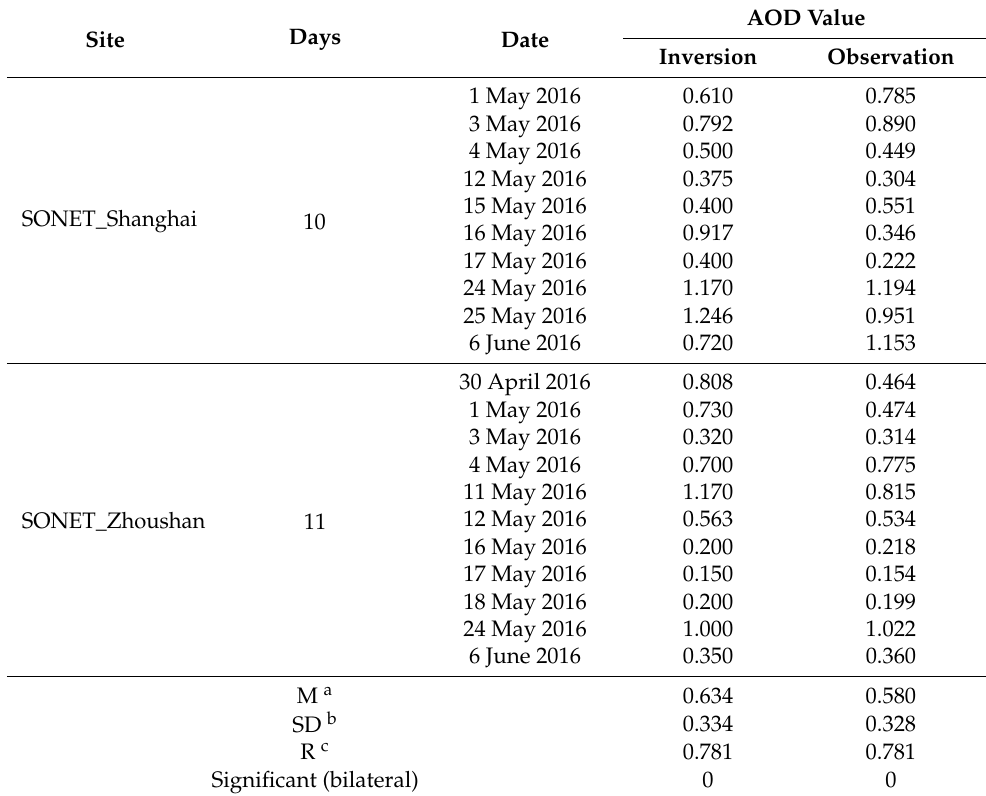
Figure 4. Seasonal inversion AODs in SHB. Table 5. Pearson correlation analysis of inversion AOD and observation